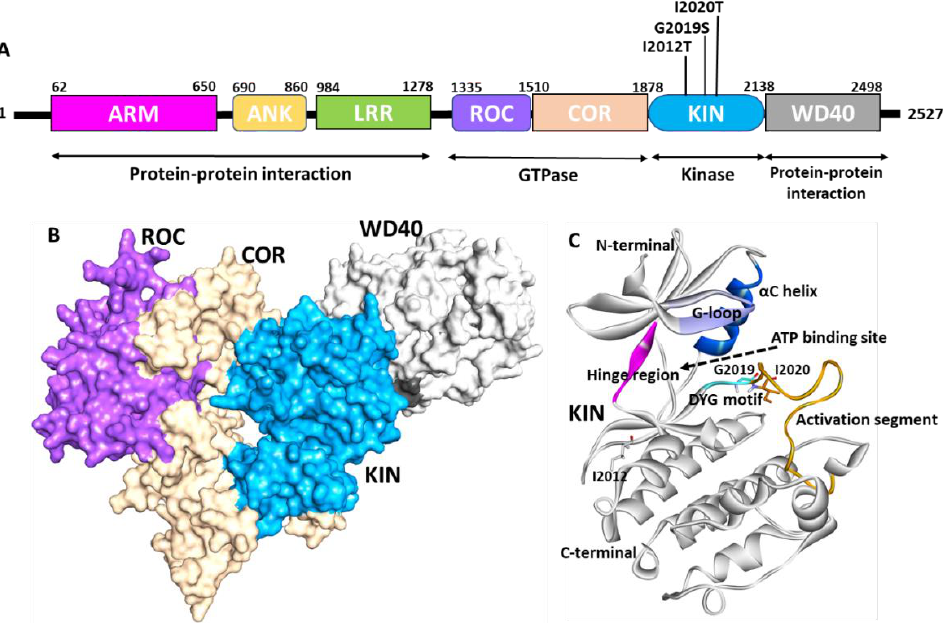
Figure 1. Structure of LRRK2. ( A ) Domain organization of LRRK2. ARM—Armadillo repeats (pink), ANK—ankyrin repeats (yellow), LRR—leucine-rich repeat (green), ROC—Ras of complex (purple), COR—C terminal of Roc (cream), KIN—kinase domain (blue), WD40—WD repeat domain (grey). The mutation of the kinase domain is highlighted in black. The function of each domain is marked below the 2D diagram. ( B ) Surface representation of the cryo-EM structure of LRRK2. The color code was used the same as shown in the domain diagram. ( C ) Kinase domain of LRRK2. Active site region G-loop (purple), hinge (pink), DYG motif (cyan), α C-helix (blue), activation segment (orange) are highlighted. The position of mutation associated with PD is shown by stick representation. Figure created using Discovery Studio (DS) v19 (access date 10 February 2022) [55].